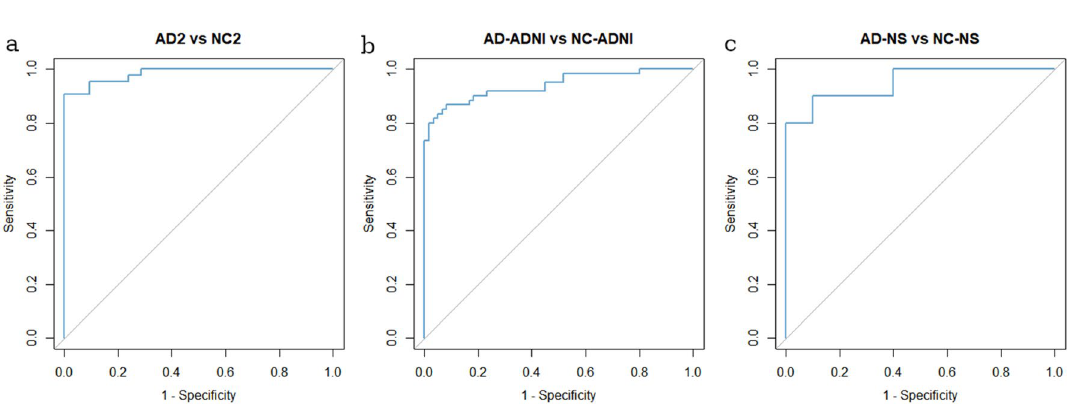
Figure 4. Receiver operating characteristic (ROC) curves for Alzheimer’s dementia (AD) and normal controls (NCs) on ( a ) the internal validation set, ( b ) external validation set from Alzheimer’s Disease Neuroimaging Initiative (ADNI) and ( c ) external validation set from Northshore